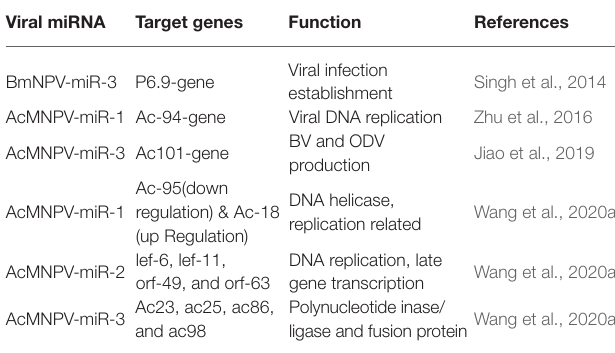
TABLE 2 | Viral micro RNA can target viral own